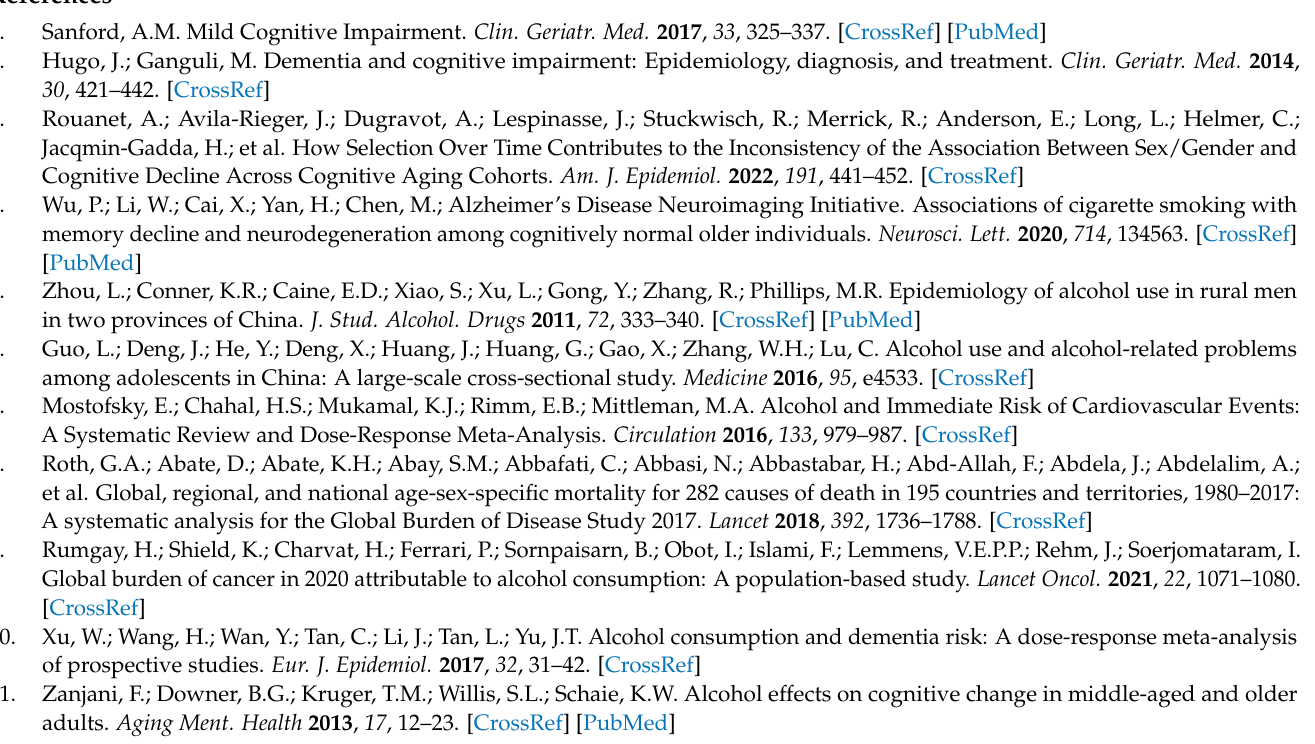
Figure S1: Sensitivity Analyses for the Trajectory of Late-Life Cognitive Decline with